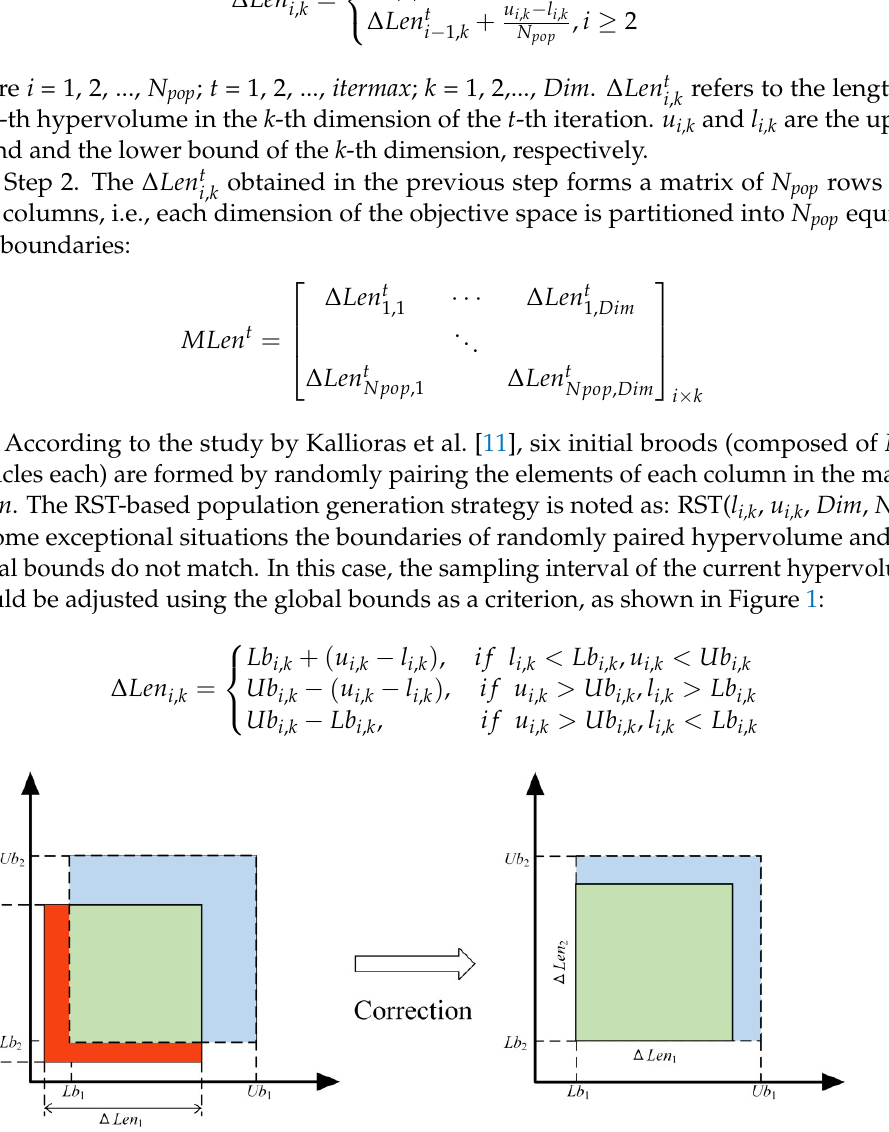
Figure 1. RST correction when the bounds of the hypervolume are outside of the global bounds.